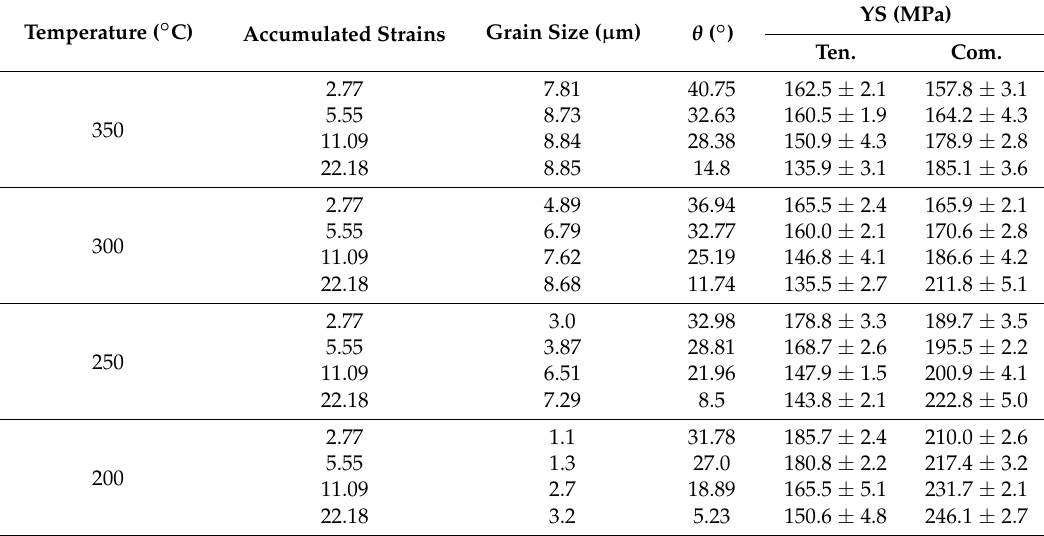
Table 2. Summarized mechanical properties of the CECed ZK61 alloy